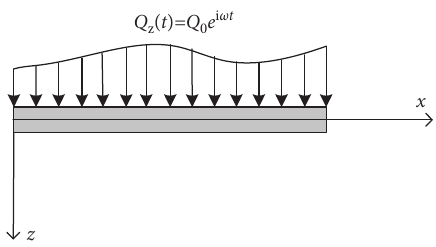
Figure 1: Incompressible nonlocal saturated poroelastic beam under vertical harmonic